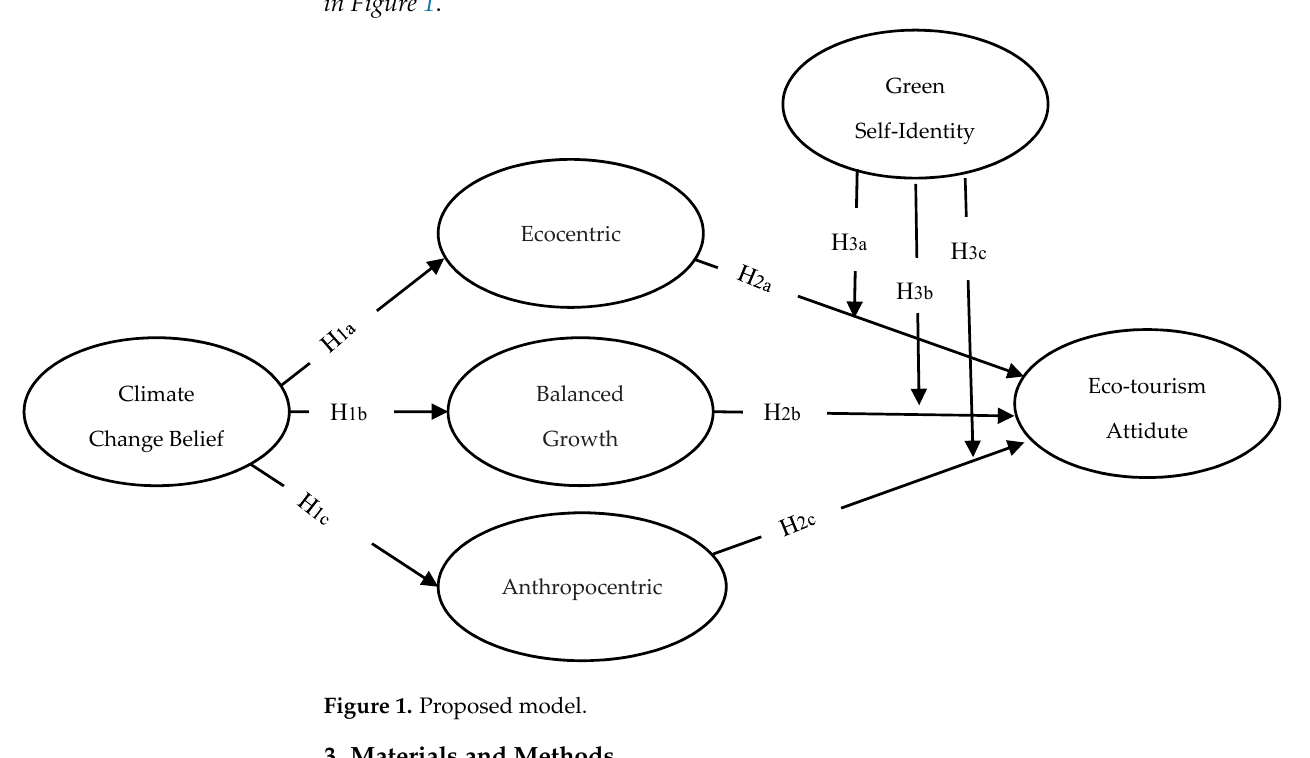
Figure 1. Proposed model